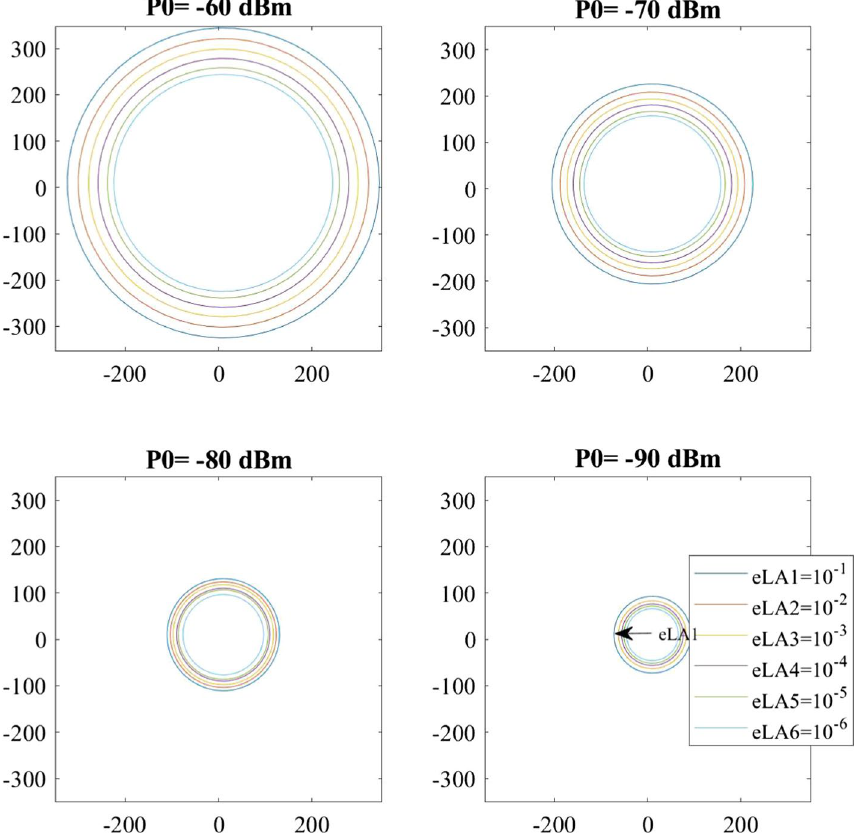
Fig. 9 Impact of P0 on the error‑limited area, eLA, where eLA is an area that sub‑granting signaling is received reliably. P0 is the desired received signal in the open‑loop power control equation